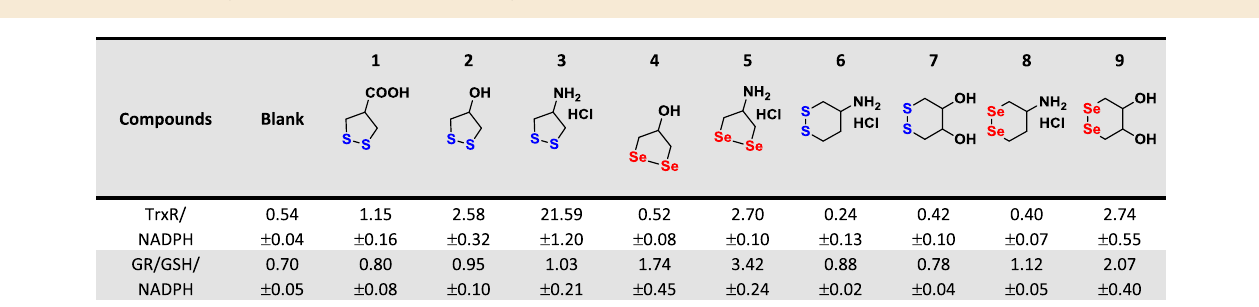
Table 3 Reduction of cyclic disul fi des/diselenides by TrxR and GSH a